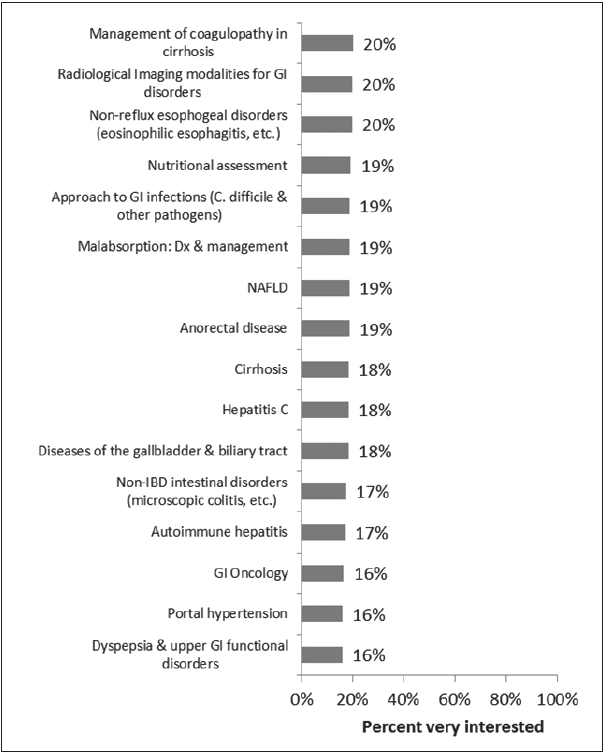
Figure 4) Educational topics in which 3% to 11% of respondents were ‘very interested’. EUS Endoscopic ultrasound; MOC Maintenance of